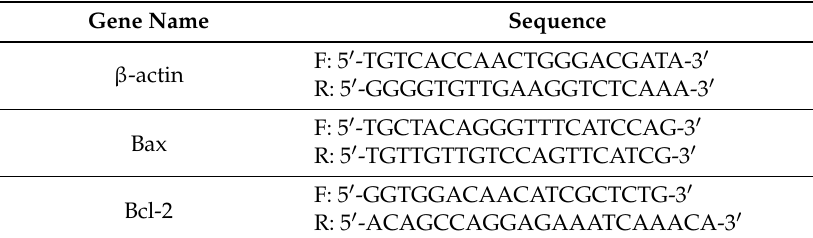
Table 1. The primer sequences for quantitative PCR